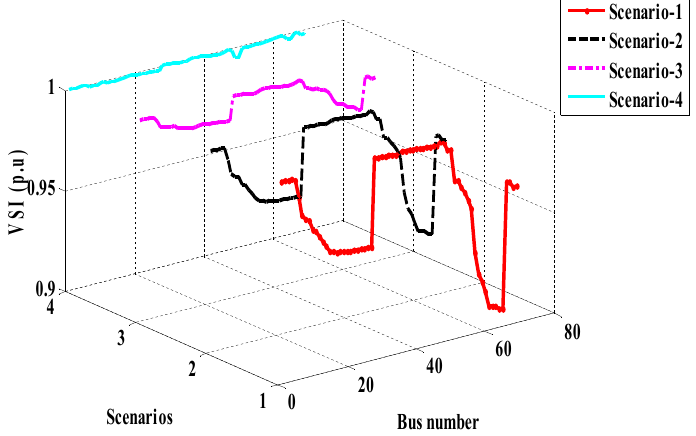
Figure 13. Comparison of VSI of 69-bus system at normal load.